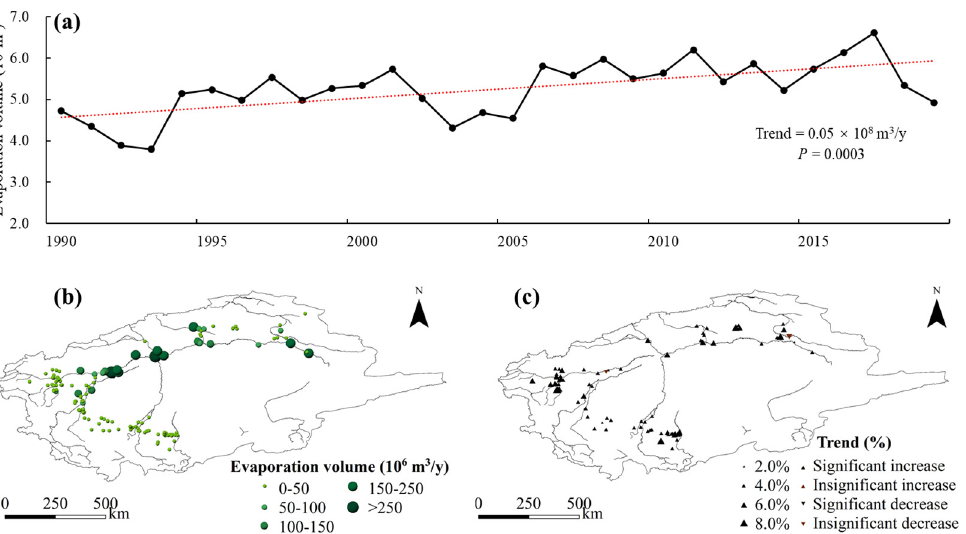
Figure 6. Evaporation losses of reservoirs in TB from 1990 to 2019: ( a ) Interannual variation trend of reservoir evaporation losses; ( b ) reservoir evaporation losses; and ( c ) variation trend of reservoir evaporation losses.